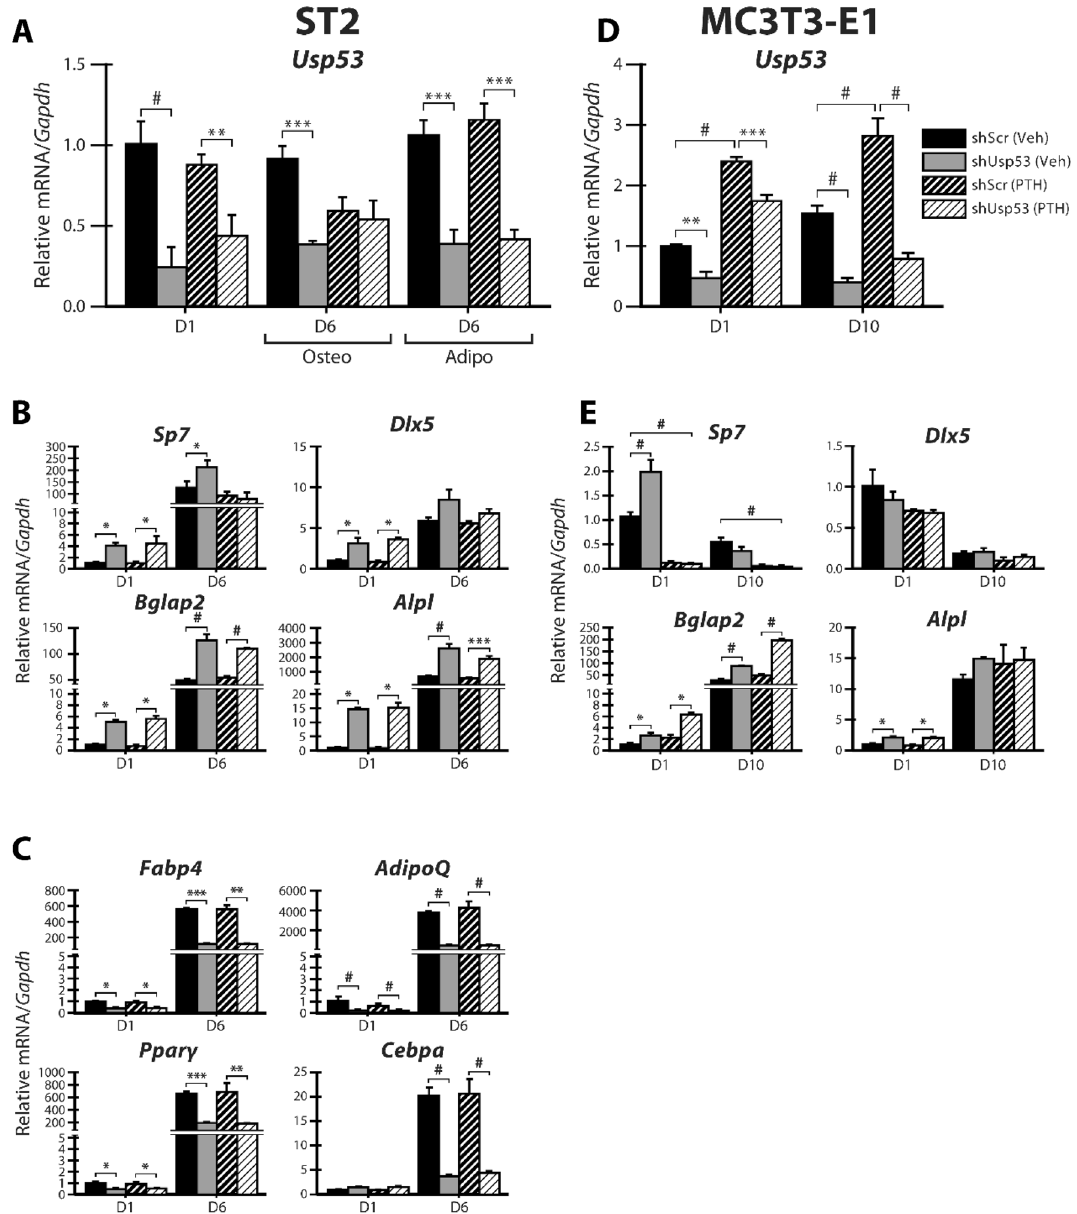
Figure 7. PTH responses in Usp53 knockdown osteoblasts and adipocytes. ST2 cells expressing scrambled shRNAs (shScr) targeting control and shRNAs targeting Usp53 were grown under osteogenic or adipogenic conditions for 6 days. Gene expression analysis of Usp53 ( A ) osteogenic ( B ) or adipogenic ( C ) differentiation markers. Quantitative RT-qPCR using TaqMan probes against osteoblast or adipocyte differentiation markers, normalized to Gapdh , was performed on RNA isolated from shScr-stably transfected or shUsp53-stably transfected pools of ST2 cells grown for 6 days in osteogenic or adipogenic medium treated with vehicle or 100 nM PTH(1–34) for 2 h prior to analysis. Gene expression analysis of Usp53 ( D ) or osteogenic ( E ) differentiation markers of MC3T3-E1 cells. Quantitative RT-qPCR using TaqMan probes against osteoblast differentiation markers, normalized to Gapdh , was performed on RNA isolated from shScr-stably transfected or shUsp53-stably transfected pools of MC3T3-E1 cells grown for 10 days in osteogenic medium treated with vehicle or 100 nM PTH(1–34) for 2 h prior to analysis. Results are presented as the mean fold change ± SD. * P ≤ 0.05; ** P ≤ 0.01; *** P ≤ 0.001; # P < 0.0001; ANOVA with Bonferroni’s post-hoc test for all